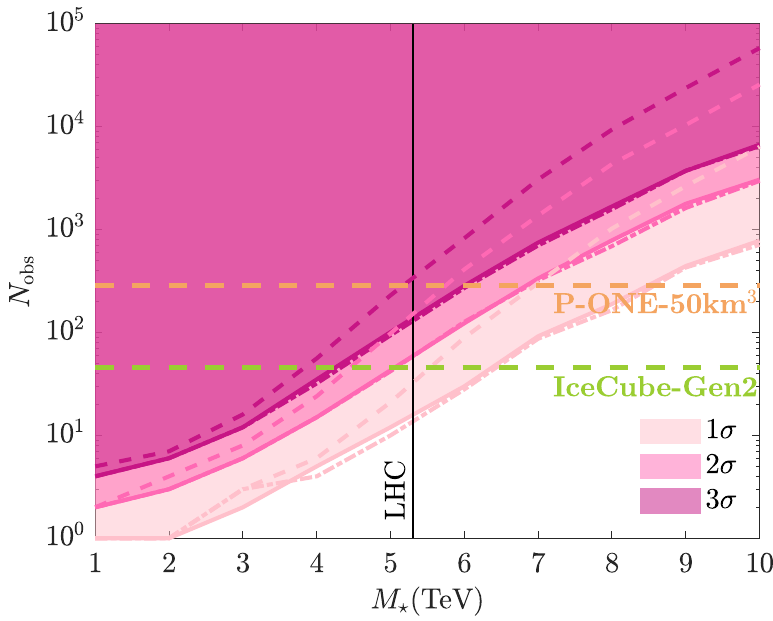
Figure 11 . Total number of observations required to exclude black hole production as a function of M ? . The shaded regions from light to dark correspond to 1 (cid:27) , 2 (cid:27) and 3 (cid:27) CL with all showers , muon tracks and dobule bang events included. Dashed pink lines from bottom to top show the 1 (cid:27) , 2 (cid:27) and 3 (cid:27) CL using only information from showers while the dash-dotted pink lines use both showers and muon tracks. Dashed green and orange lines depict the expected total number of observations at IceCube-Gen2 and P-ONE within 10 years assuming SM only interactions. LHC bound on M ? at 95% CL for n = 6 extra dimensions is shown in black for